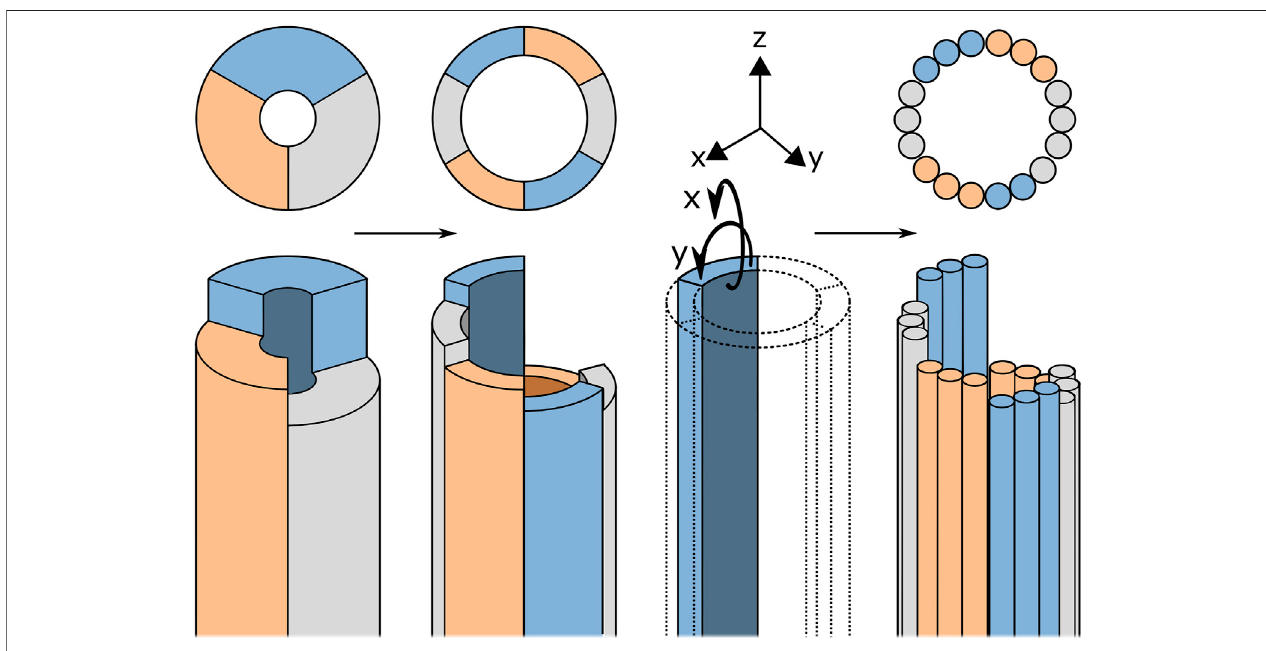
FIGURE 4 | Schematic representation of the design process from the rigid transport mechanism described by Sakes et al. (2020)) to the fl exible blades. For explanation, see text.